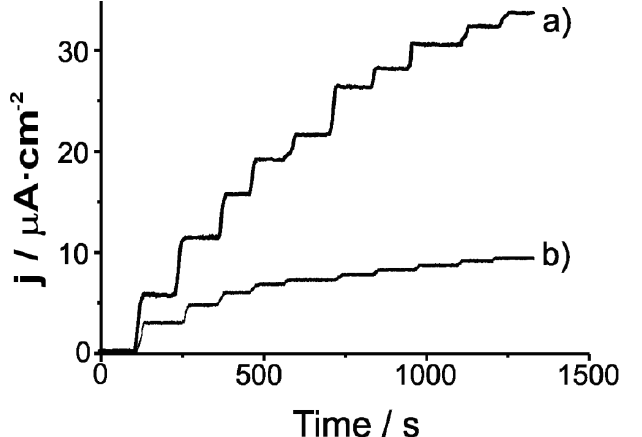
-LB and ( b ) Ty/LuPc 2